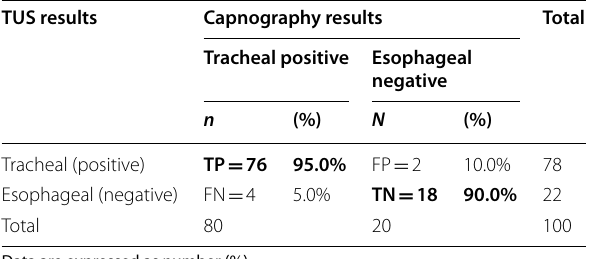
Data are expressed as number (%) TUS Tracheal ultrasonography, TP True positives, FP False positives, FN False negatives, TN True negatives Text in bold indicates p -values <0.001